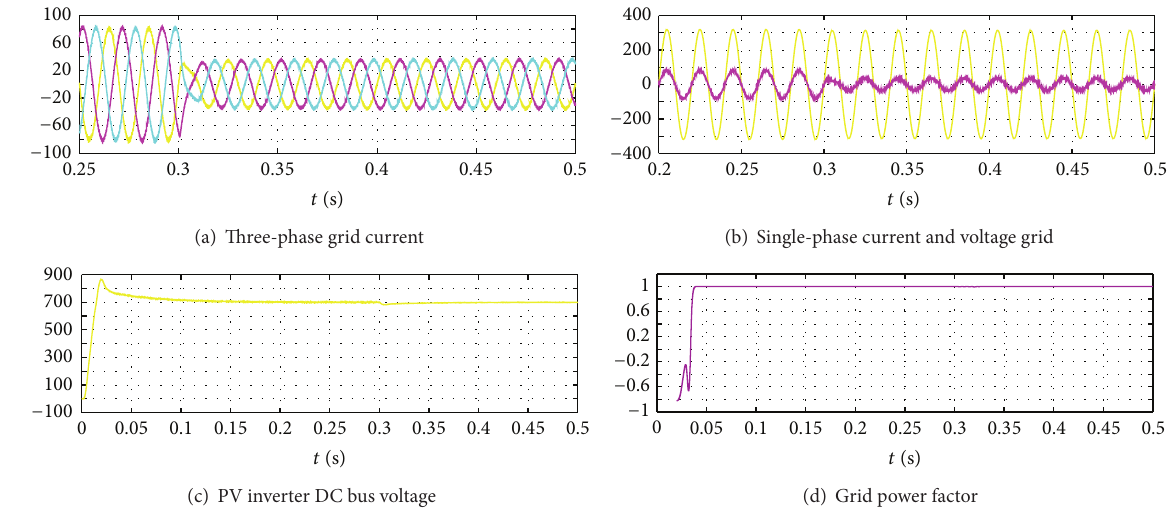
Figure 6: The results of output three-phase grid-connected inverter simulation.